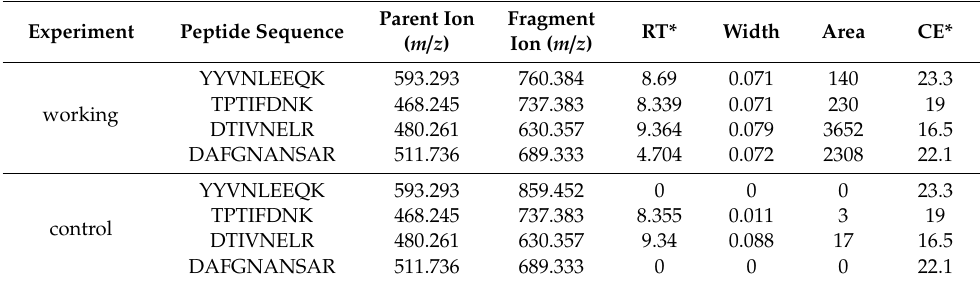
Table 2. The list of transitions for SRM analysis, obtained in experiments with SuccBB-activated (working experiment) and non-activated (control experiment) AFM substrate surface incubated in 10 − 9 M HRP solution.